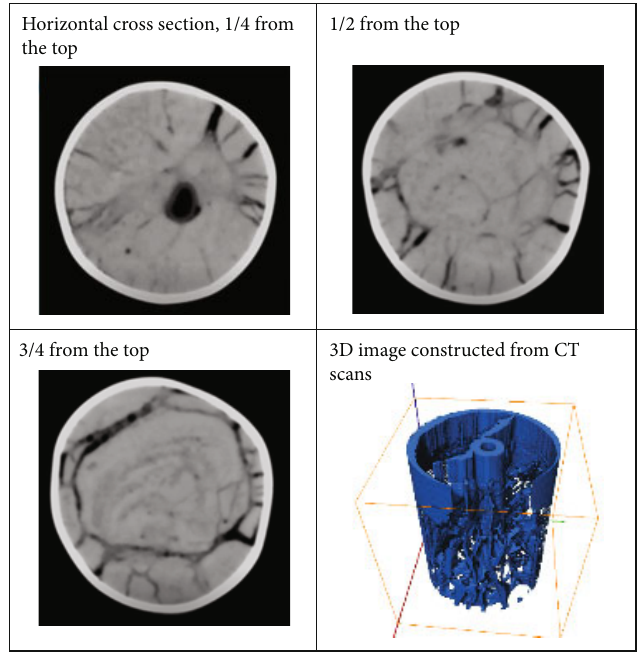
Figure 6: CT scan images showing a complex fracture pattern. Sample B7.